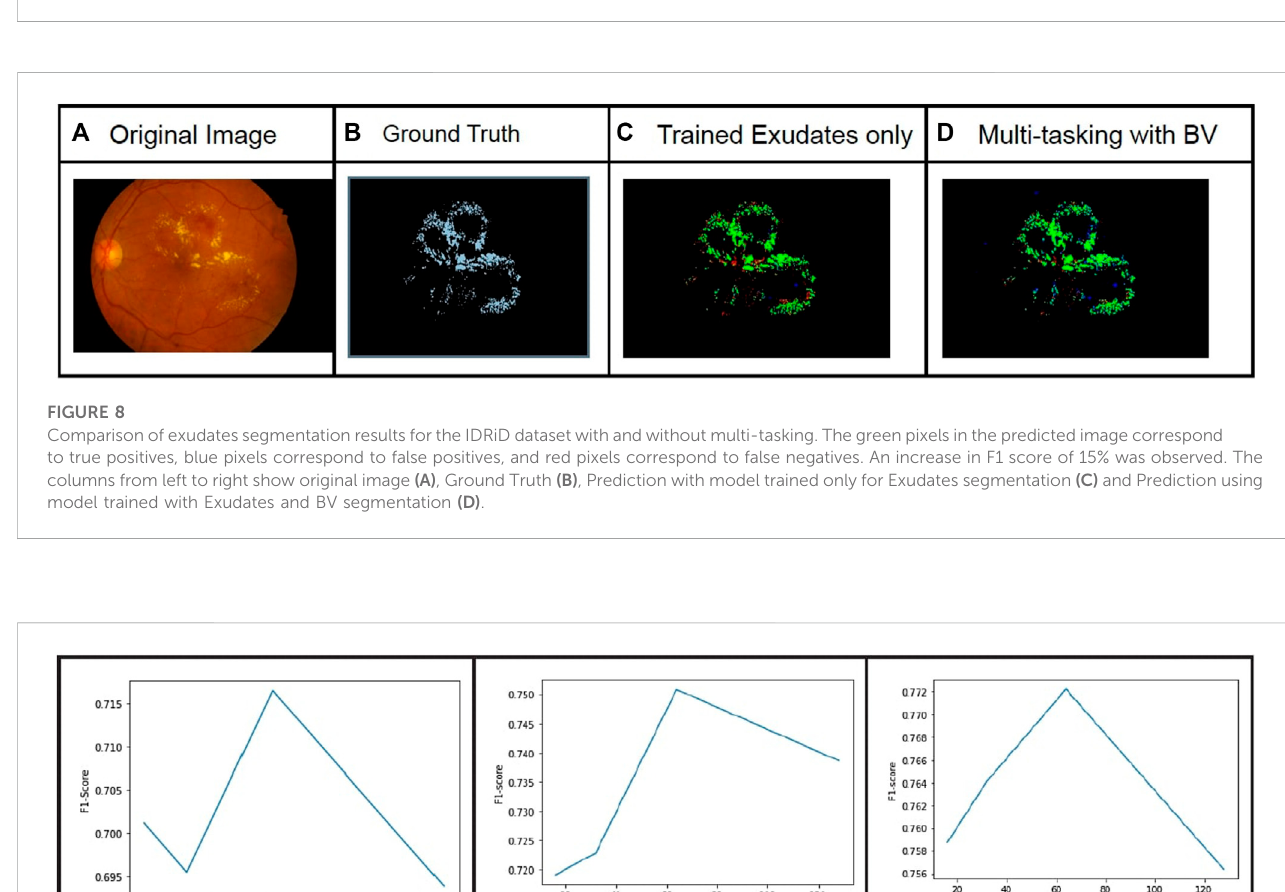
FIGURE 7 ComparisonofmaculasegmentationresultsfortheIDRiDdatasetwithandwithoutmulti-tasking.Thegreenpixelsinthepredictedimagecorrespondto true positives, blue pixels correspond to false positives, and red pixels correspond to false negatives. An increase in F1 score of 58% was observed for this image.The columns from left to right show original image (A) , Ground Truth (B) , Prediction with model trained only for Fovea segmentation (C) and Prediction using model trained with Fovea and BV segmentation (D) .